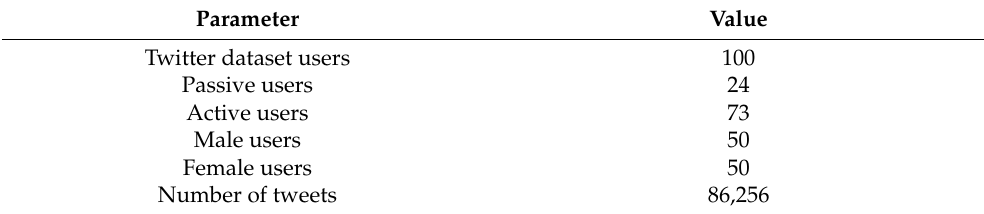
Table 5. Dataset